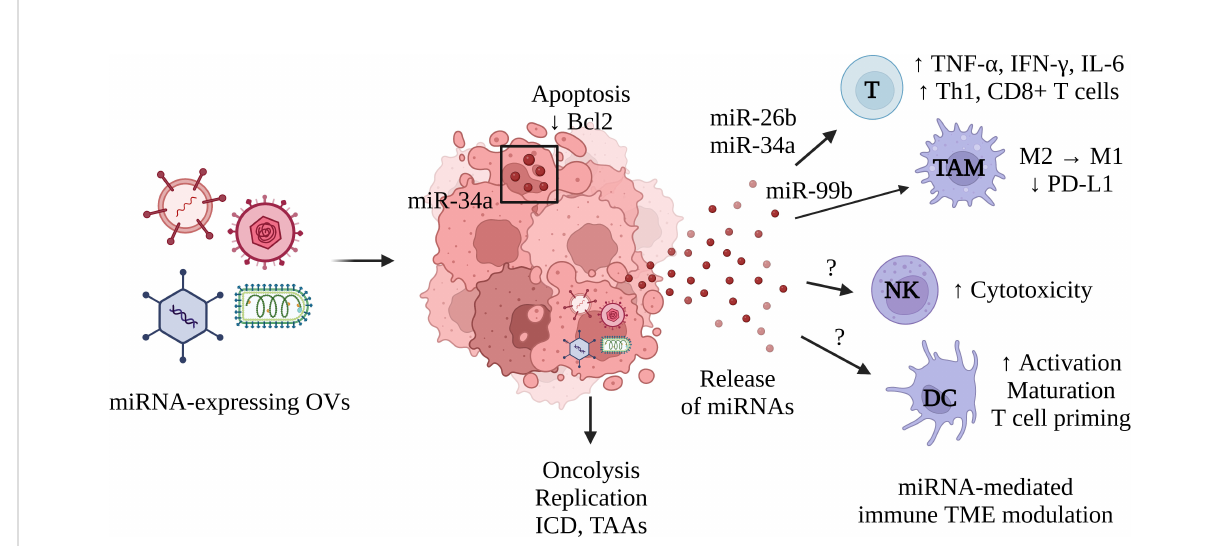
FIGURE 1 Schematic representation of the immune TME remodeling induced by miRNA expressed from OVs. OVs expressing miRNAs infect cancer cells and produce miRNAs capable of spreading across the TME and modulating immune function. This process can be used to improve the function of effector T cells, stimulate a Th1 response, activate CD8+ T cells, or to favor an M1-like phenotype in TAMs. This mechanism could be leveraged to stimulate the effector functions of NK cells or to recruit and activate DCs. MiRNAs can also regulate gene expression in infected cancer cells and increase their immunogenicity, by inducing cell death or altering their immune pro fi le. Oncolysis enables viral replication as well as the release of tumor-associated antigens (TAAs). This process is characterized by an immunogenic form of cell death termed immunogenic cell death (ICD) and the immunomodulatory molecules it produces (ecto-calreticulin, adenosine triphosphate, high mobility group box 1, etc.). T, T cells; TAM, tumor-associated macrophages; NK, Natural killer cells, DC, Dendritic cells. Created with